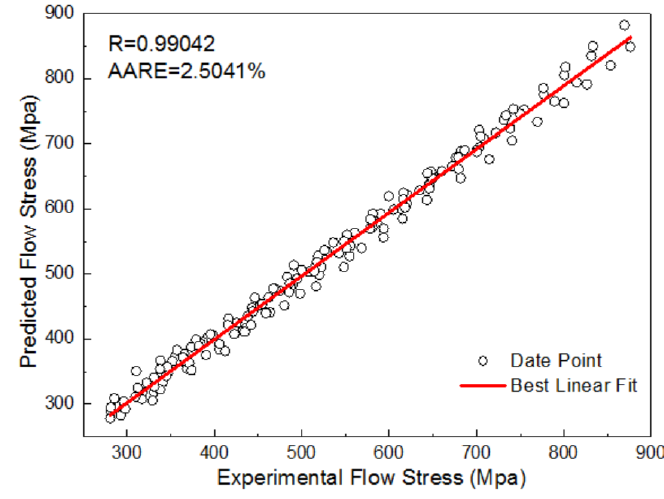
Figure 12. The comparison between the predicted data and the experimental data by WHM.